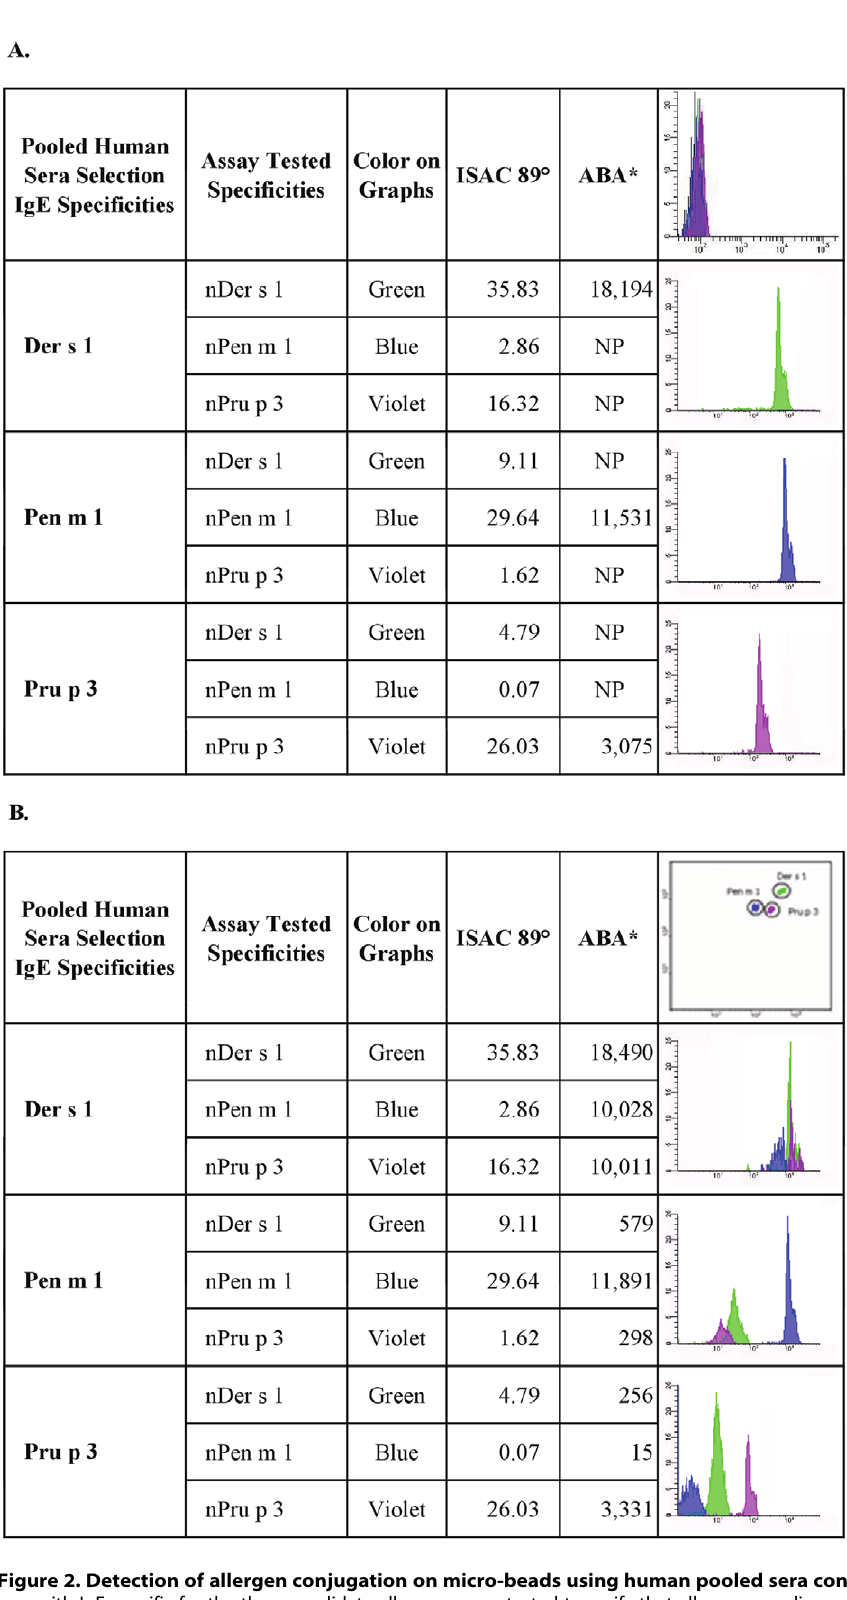
Figure 2. Detection of allergen conjugation on micro-beads using human pooled sera containing specific IgE. Selected pooled human sera with IgE specific for the three candidate allergens were tested to verify that allergen coupling was acceptable also for human immunoglobulin determination and to estimate interference among different allergen-conjugated micro-beads. Panel A: Each serum pool was tested on the respective allergen-coupled micro-bead. The other two micro-beads were not in the tube. NP: Not performed in this singlepex testing. u Values are expressed as kU/l. * Values are expressed as Median Fluorescence Intensity [MFI]. Upper right corner: an example of blank fluorescence reading of conjugated micro-beads without serum. Panel B: Serum pools were tested on the three allergen-coupled micro-beads present in the same tube. u Values are expressed as kU/l. * Values are expressed as Median Fluorescence Intensity [MFI]. Upper right corner: an example of micro-bead fluorescence clusters. doi:10.1371/journal.pone.0035697.g002 PLoS ONE |